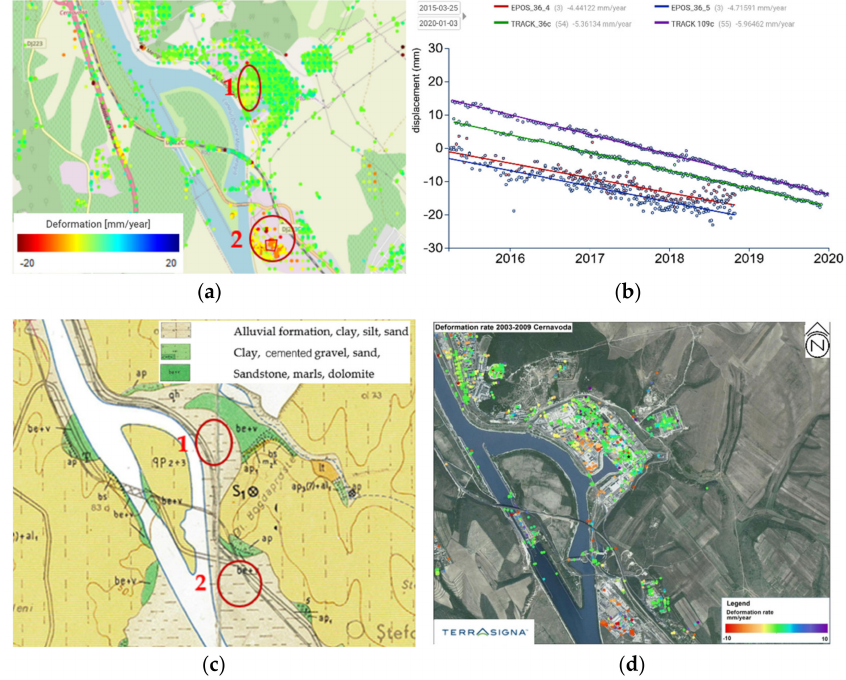
Figure 11. Correlation between geology and measured ground displacement: ( a ) Sentinel-1 ground displacement map; ( b ) Sentinel-1 LOS time-series displacement (area 2); ( c ) geology of the